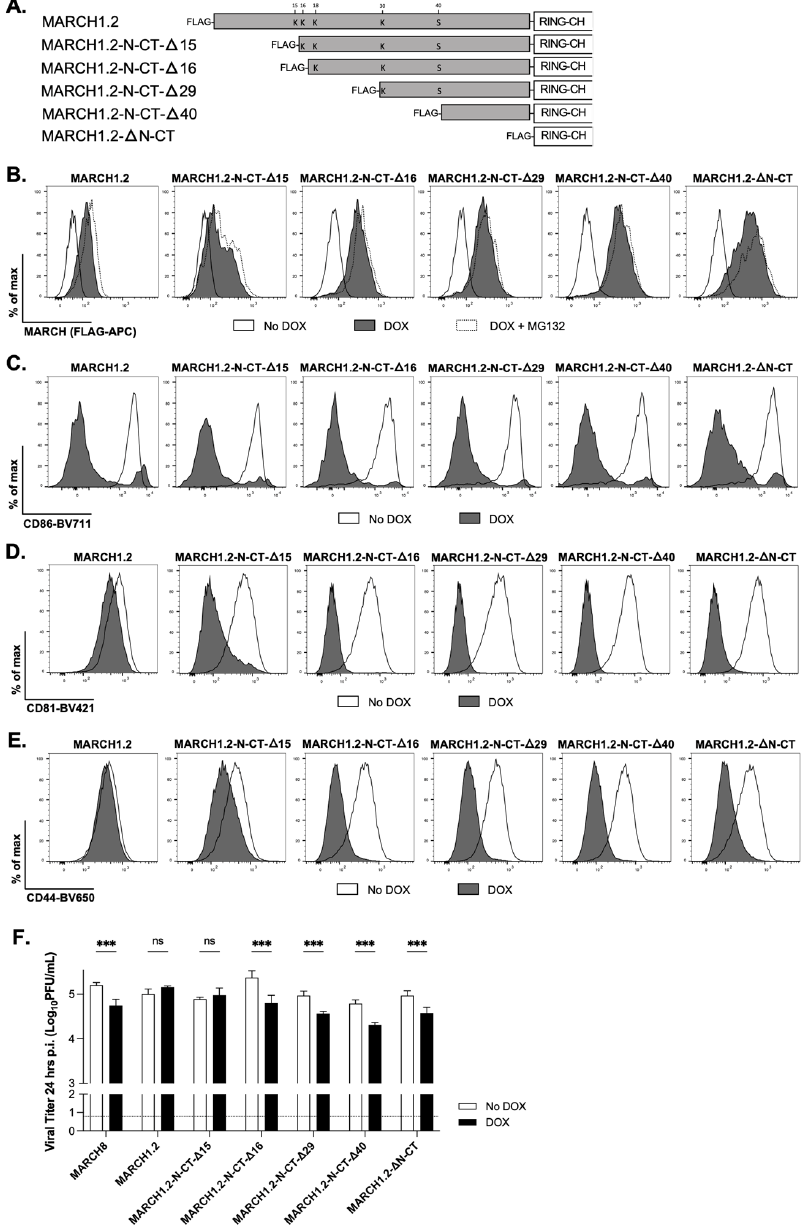
Figure 4. Deletion of 16 residues from the N-terminal of the MARCH1.2 N-CT domain restores its ability to restrict IAV replication . ( A ) Schematic of the different MARCH1.2 deletion mutants utilised in this study. ( B ) Stable 293T cells with DOX-inducible expression of MARCH1.2 WT or different MARCH1.2 N-CT deletion mutants were cultured for 24 h in media alone (no DOX), sup- plemented with 1 mg/mL DOX (DOX) or with DOX in the presence of MG132 for the last 4 h of DOX induction (DOX + MG132). Protein expression of WT and MARCH1.2 mutants was determined by intracellular staining with an anti-FLAG mAb followed by flow cytometry. ( C ) The cells were trans- fected with a plasmid encoding CD86 and ZsGreen fluorescent protein. At 12 h post-transfection, MARCH expression was (DOX) or was not (no DOX) induced as above and 24 h later the cells were stained for cell-surface CD86 expression. ( D , E ) No DOX or DOX-induced cells were detached, washed and stained for cell-surface expression of CD81 ( D ), or CD44 ( E ). In ( C – E ) representative histograms from triplicate samples are shown. ( F ) Cells cultured overnight were infected with IAV strain Beij/89 (MOI = 5 PFU/cell) for 1 h at 37 °C, washed and then cultured in media alone (no DOX, white bars) or media supplemented with 1 mg/mL DOX (DOX, black bars). At 24 hpi, the cell su- pernatants were harvested, clarified by centrifugation and viral titres were determined by plaque assay. The results show two-way ANOVA and Bonferroni’s post-test, no DOX to DOX. * = p < 0.05,